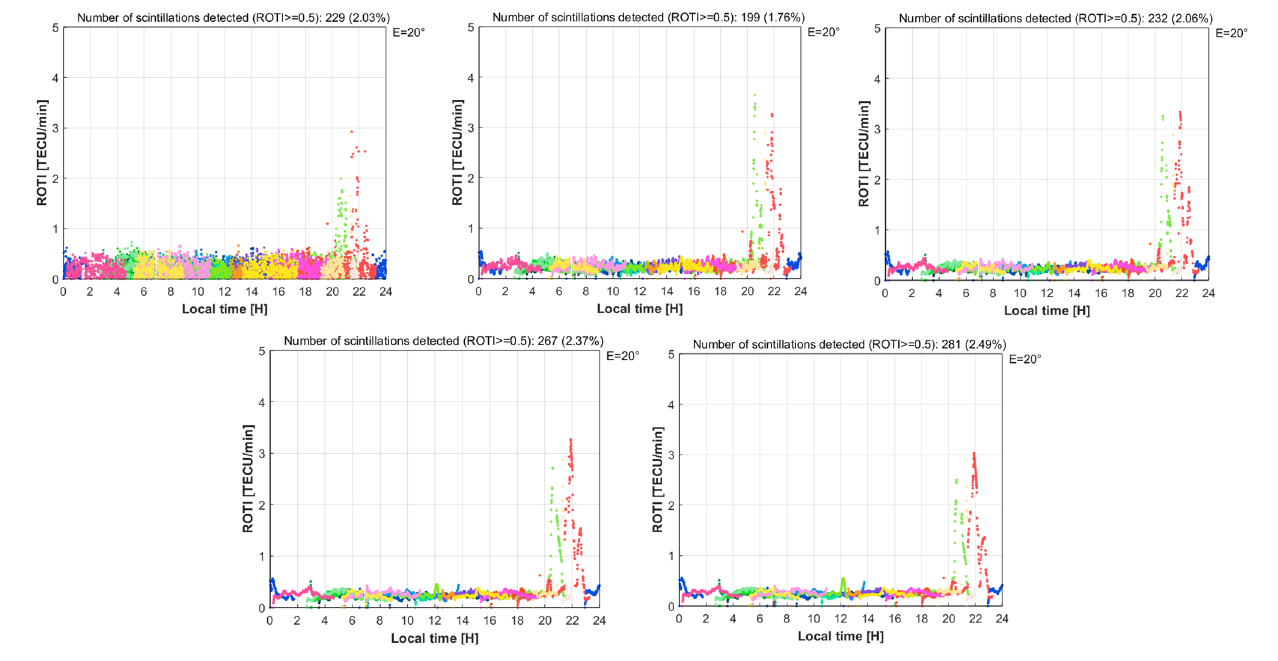
Figure 7. Comparison of scintillation events with different time spans for ROTI calculations ( top-left : 1 min; top-middle : 5 min; top-right : 10 min; bottom-middle : 15 min; bottom-right : 20 min). The greater the calculation time span, the more disturbances are detected, except for the 1 min calculation, which does not involve enough observations to capture such small-scale irregularities. The 5 min time span gives the highest reliability and is also consistent with the conventional ROTI calculations shown in published studies [18,27,38,39]. Table 2. Comparison of scintillation events with the different time spans used for ROTI calculations (elevation cut-off is 20 ◦ ).